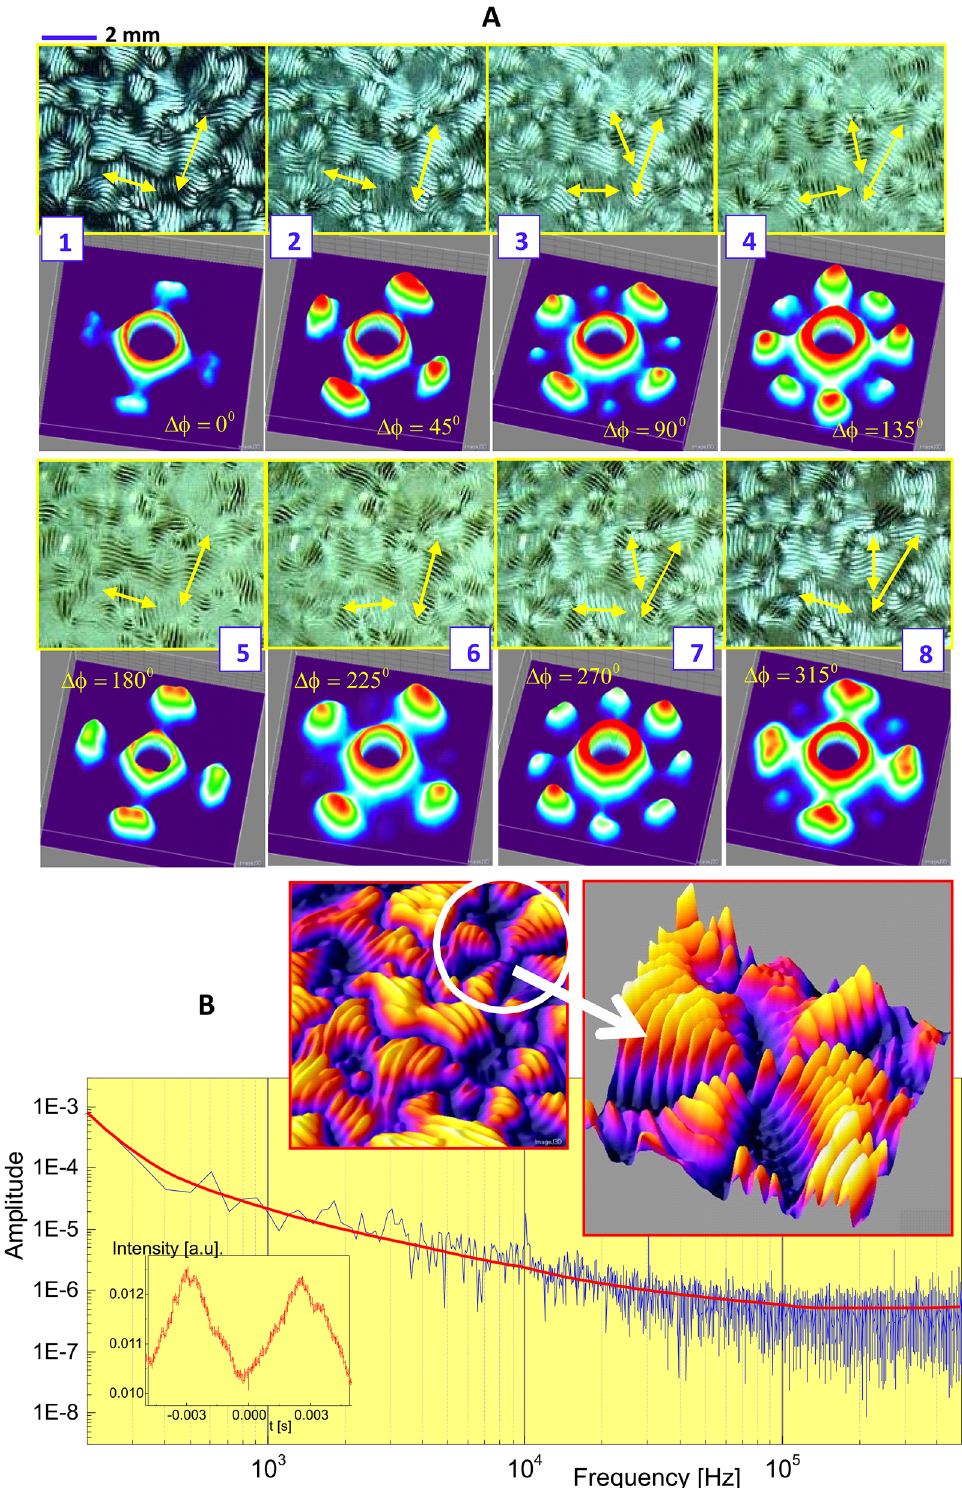
Figure 7. Optical activity of crowded charged DNA viruses (fd) in the N-star (N*) phase at a low ionic strength of 0.032 mM salt: The rotational sequence of depolarized optical morphology is shown in intervals of π/ 4 by rotating the polarization ( A ), with the corresponding orientation distribution in Fourier space. The directions of local helicity axes are indicated by the yellow arrows. Eight intensity lobes are shown for equally distributed at an angle of 270 ◦ (of the panel 7 in ( A )). ( B ): The actual optical activity of a chiral-nematic phase, measured by the Second Harmonic Generation (SHG) intensity, where the amplitude of a low frequency signal-to-noise ratio is detected as being small, but not negligible. 3D intensity maps are obtained by a software version ImageJ 1.52i in the URL link https ://image